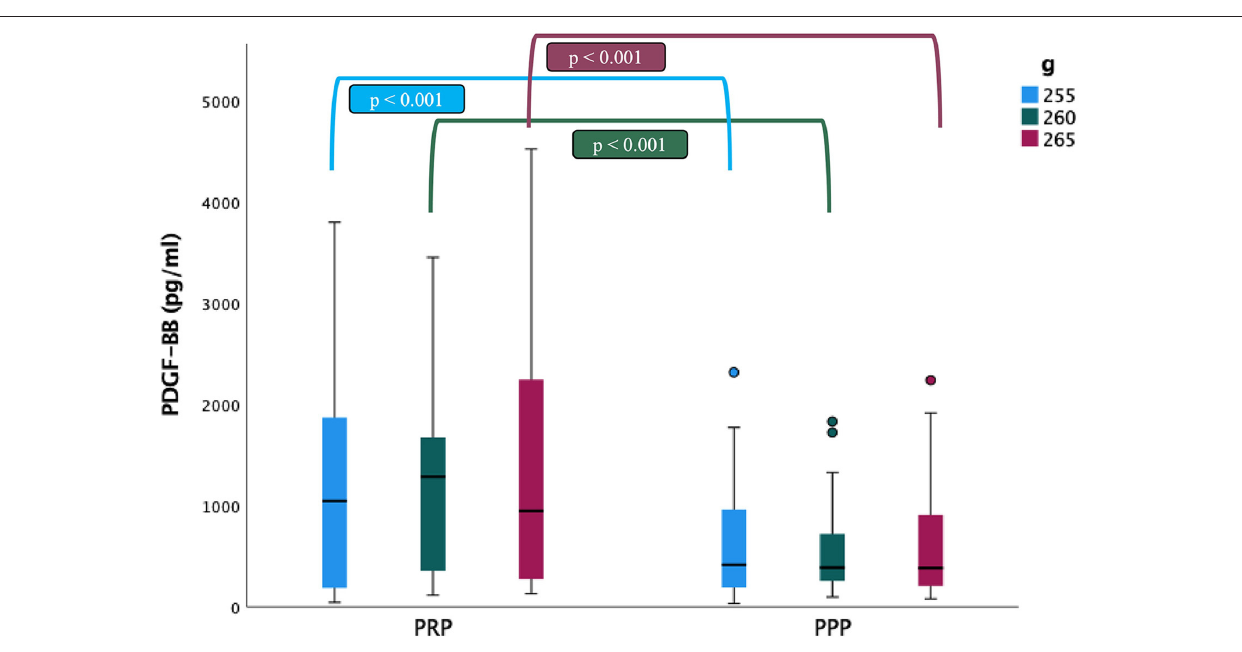
FIGURE 3 | Comparison of the platelet-derived growth factor BB (PDGF-BB) concentrations (mean ± SD) in cat ( n = 30) between PRP and PPP fractions according to the three centrifugation protocols (g: 255, 260 and 265 in 10min). • : Outlyers data included in the statistically study. a specific species may not produce the same cellular composition in any other species (22, 55). In other study, Boswell et al.